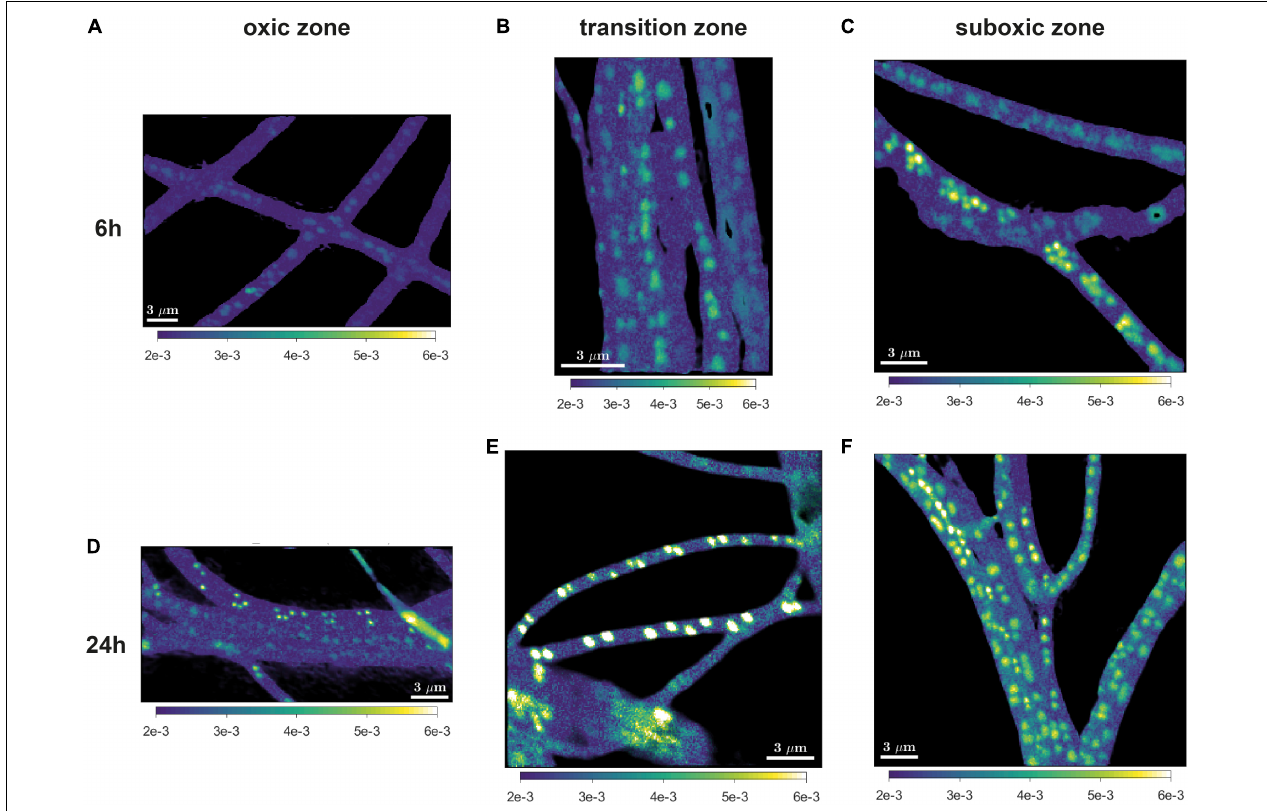
FIGURE 3 | Representative images of the 18 O atom fraction in cable bacteria. Filaments were retrieved after 6 h (A–C) and 24 h (D–F) of incubation and retrieved from the oxic (A,D) , transition (B,E) , and suboxic (C,F) zone. All scale bars are 3 µ m. Color scale in all images is the same (0.002-0.006).